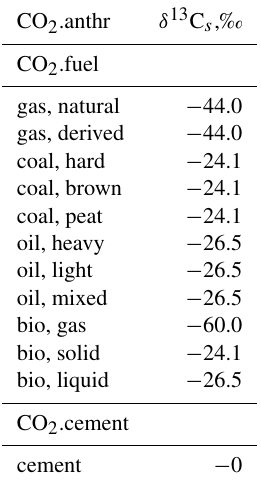
Table 2. Fuel-type-specific δ 13 C s assigned to the simulated anthro- pogenic CO 2